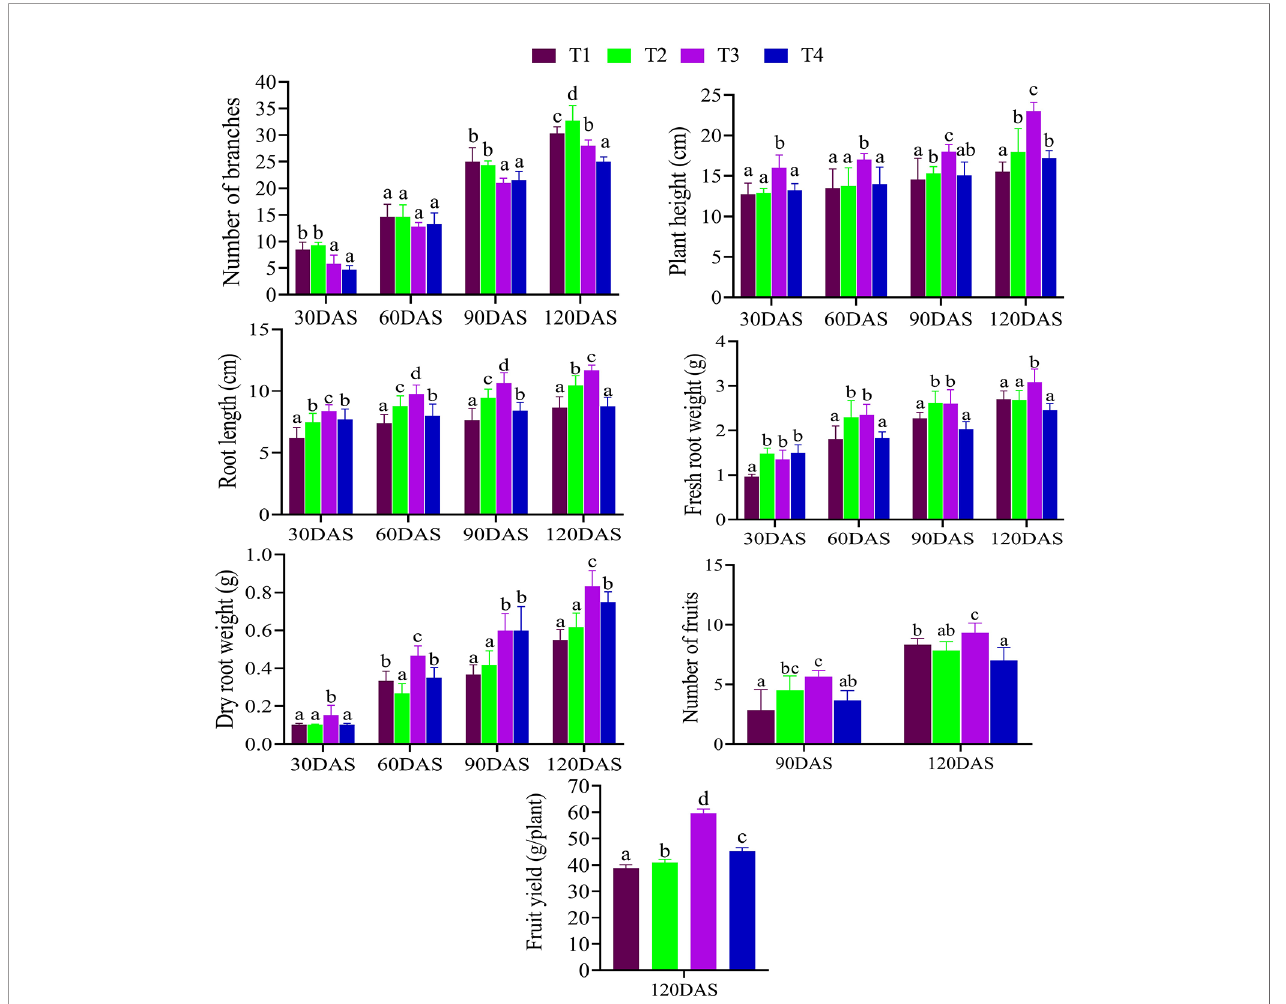
FIGURE 1 | Effects of different bacterial treatment on the various plant growth parameters of C. annuum L. at different time intervals (30 DAS, 60 DAS, 90 DAS, and 120 DAS). Where, T1: Untreated control; T2: seeds + CDK15; T3: seeds + CDK25; T4: seeds + Consortium (CDK15 + CDK25); DAS: days after sowing. All the values are in mean ± SD; (n = 6), Level of signi fi cance: p < 0.05; Values with different superscripts (a – d) are signi fi cantly different (One-way ANOVA followed by Duncan ’ s multiple range